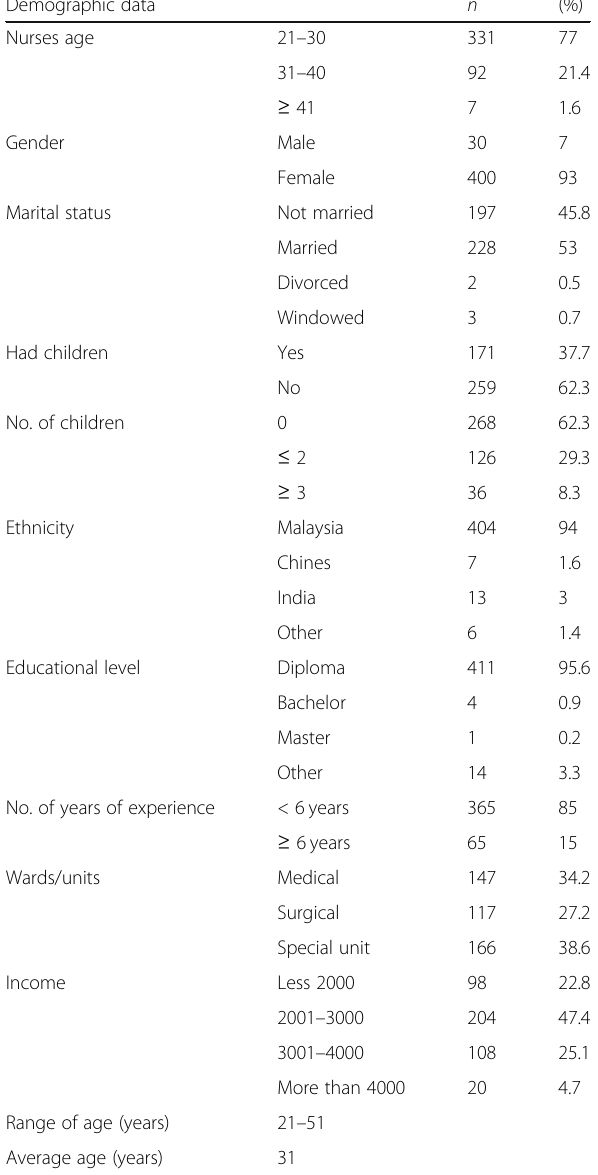
Table 1 Characteristics of nurse respondents ( n =